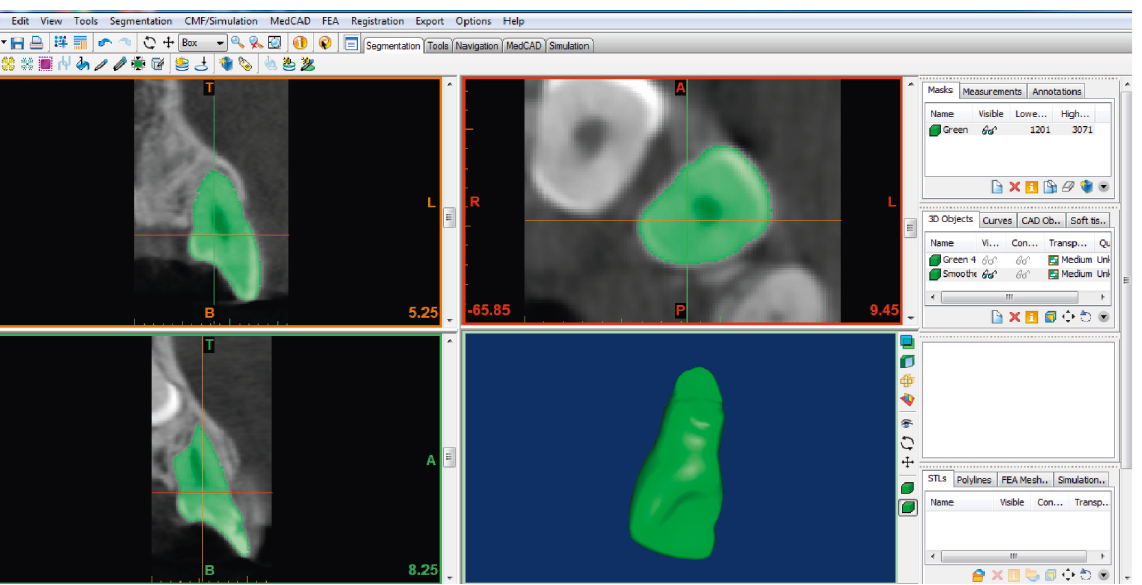
Figure 3: 3D view of a severe resorption in lateral root